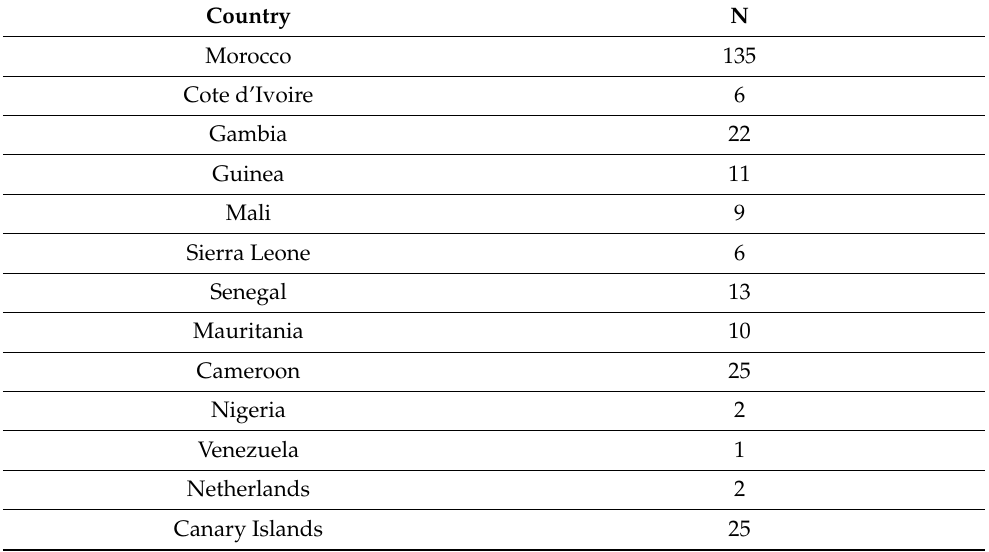
Table 2. Patient